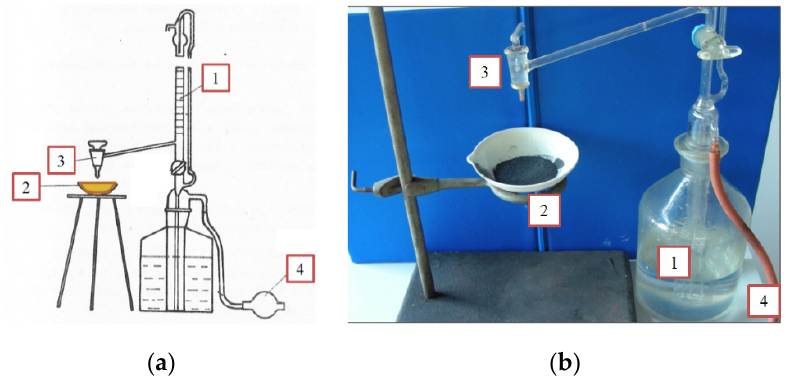
Figure 4. Apparatus for the free-fall drop test: ( a ) Scheme; ( b ) Photo; 1—Burette containing the liquid, 2—Analysed material, 3—Cock, 4—Balloon.